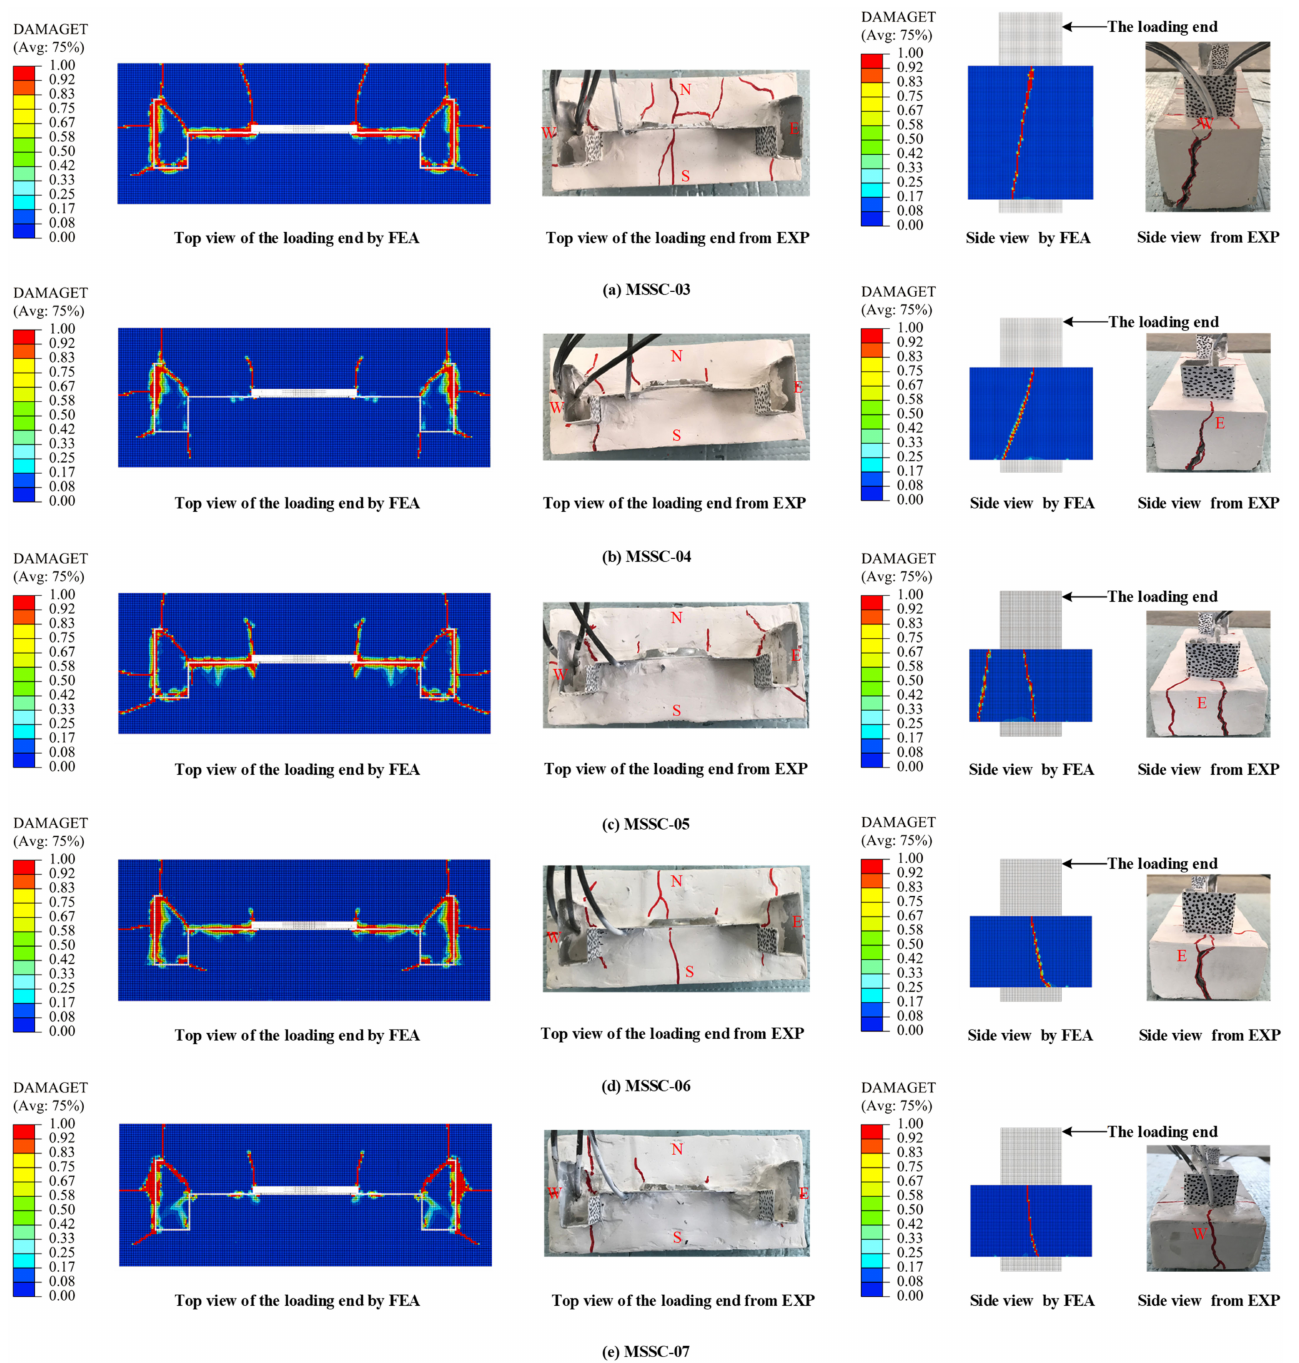
Figure 20. Comparison of FEA and EXP crack